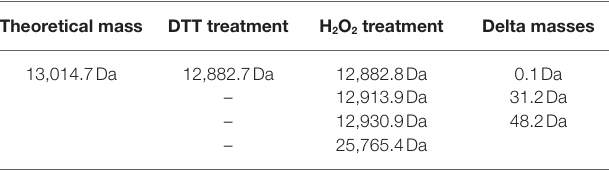
TABLE 2 | Electrospray ionization mass spectrometry analysis of reduced and H 2 O 2 -treated